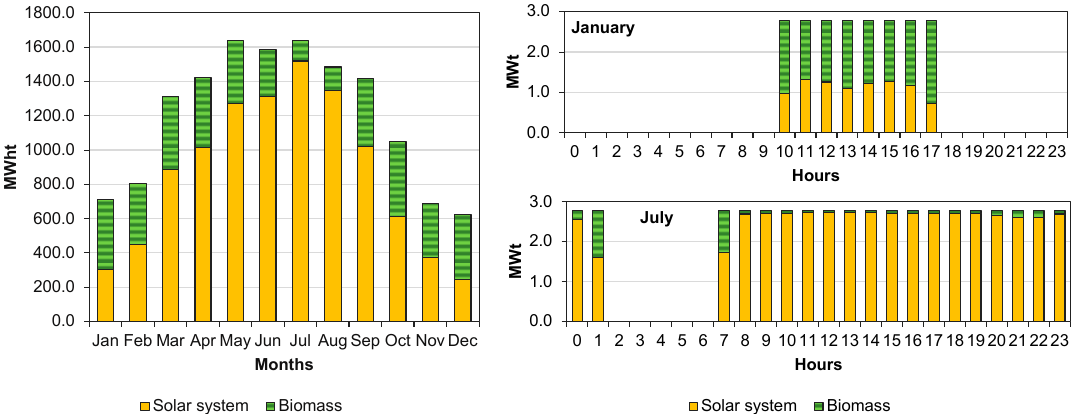
Figure 11. System A. Monthly thermal energy ( left side ) and hourly thermal energy ( right side ) of the solar system and boiler.